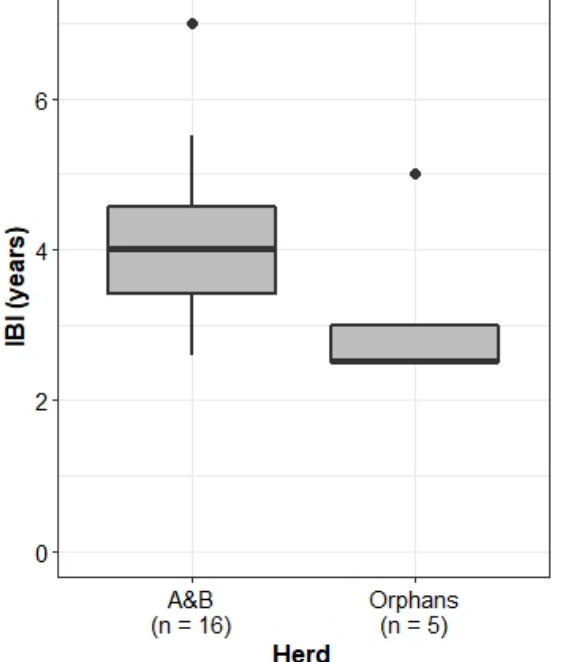
Figure 8. IBI for multiparous females in the A&B herd and the Orphans. Boxplots show median, IQR, and outliers. Numbers on the x -axis indicate the number of individuals included in the analysis for each herd.